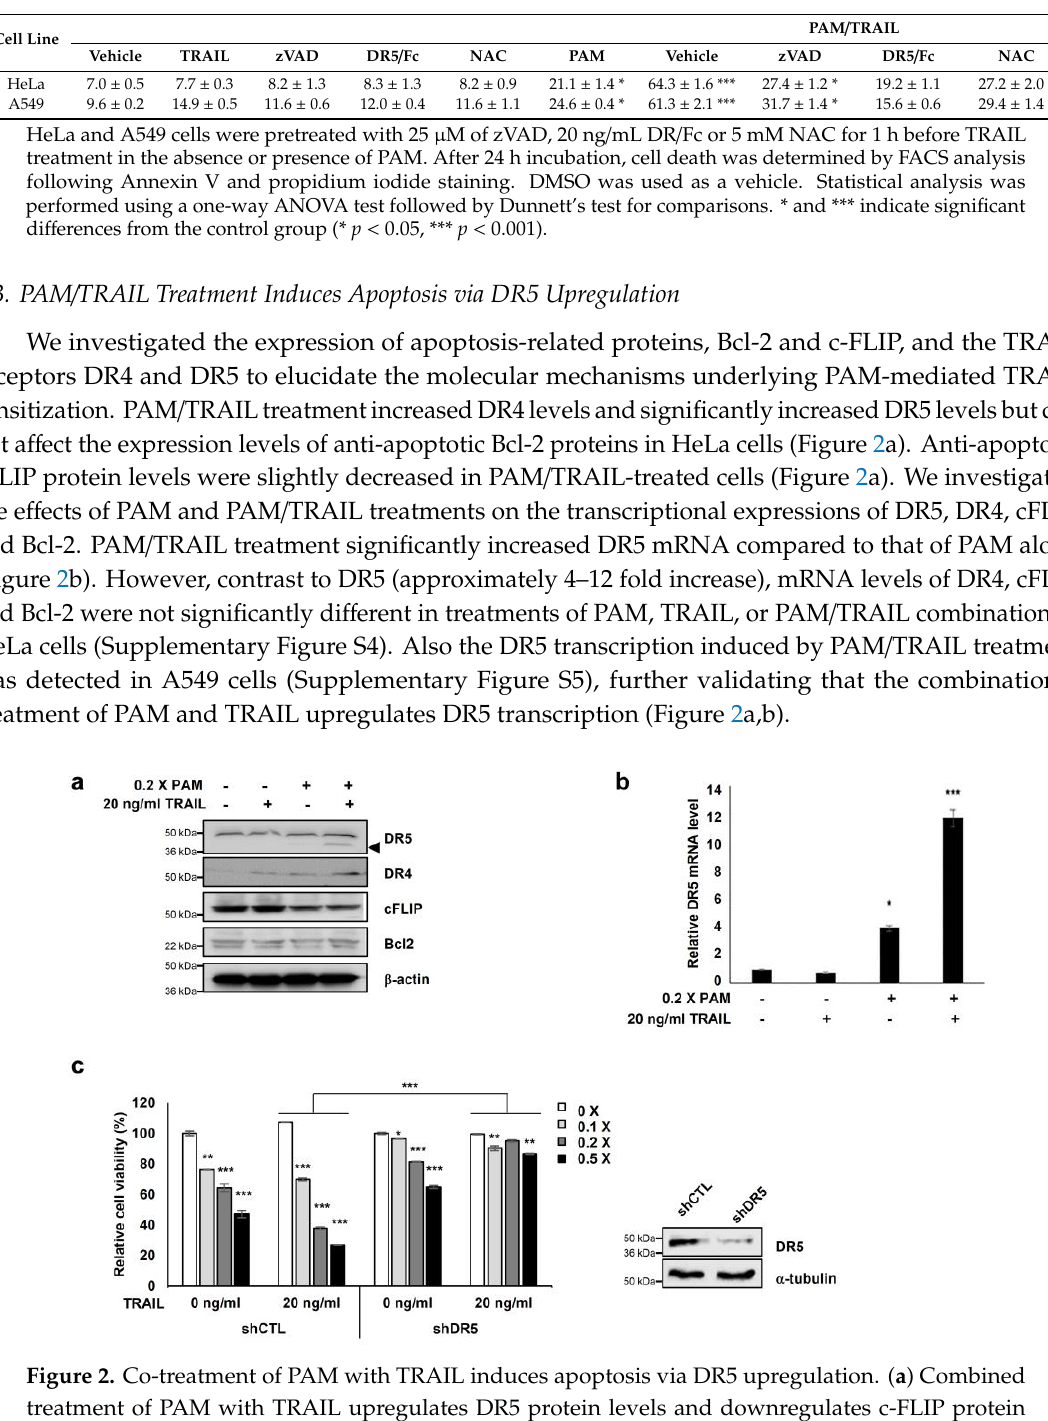
Table 2. Statistical analysis of apoptosis assay results (mean ± SD (%)).